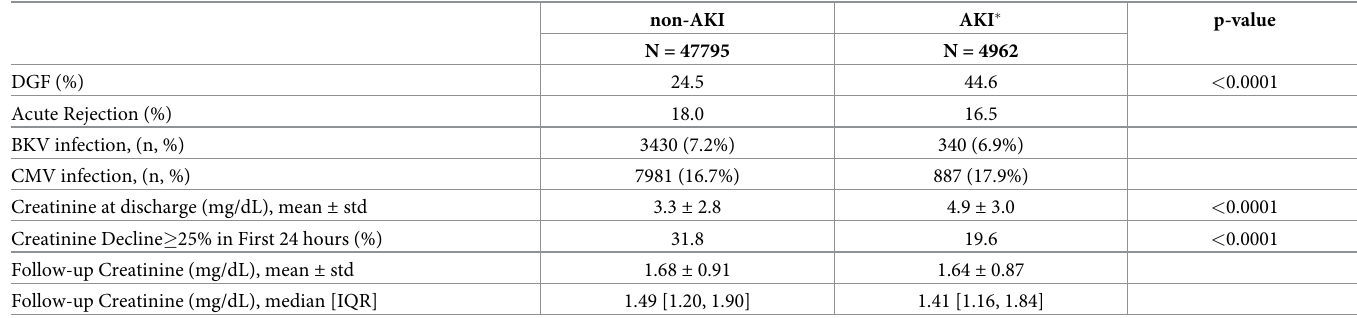
Table 2. Transplant